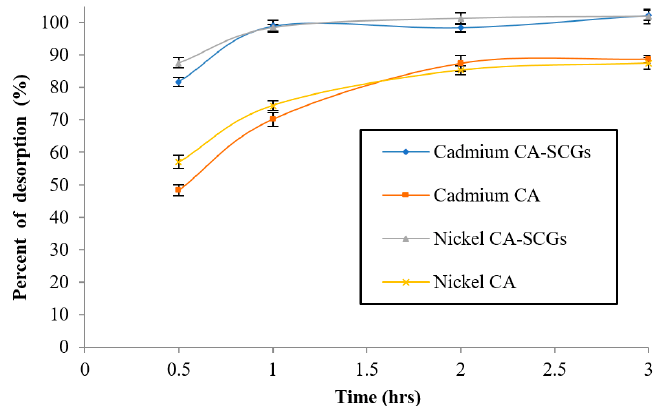
Figure 15. Effect of time in the first cycle of desorption. Figure 15. E ff ect of time in the first cycle of